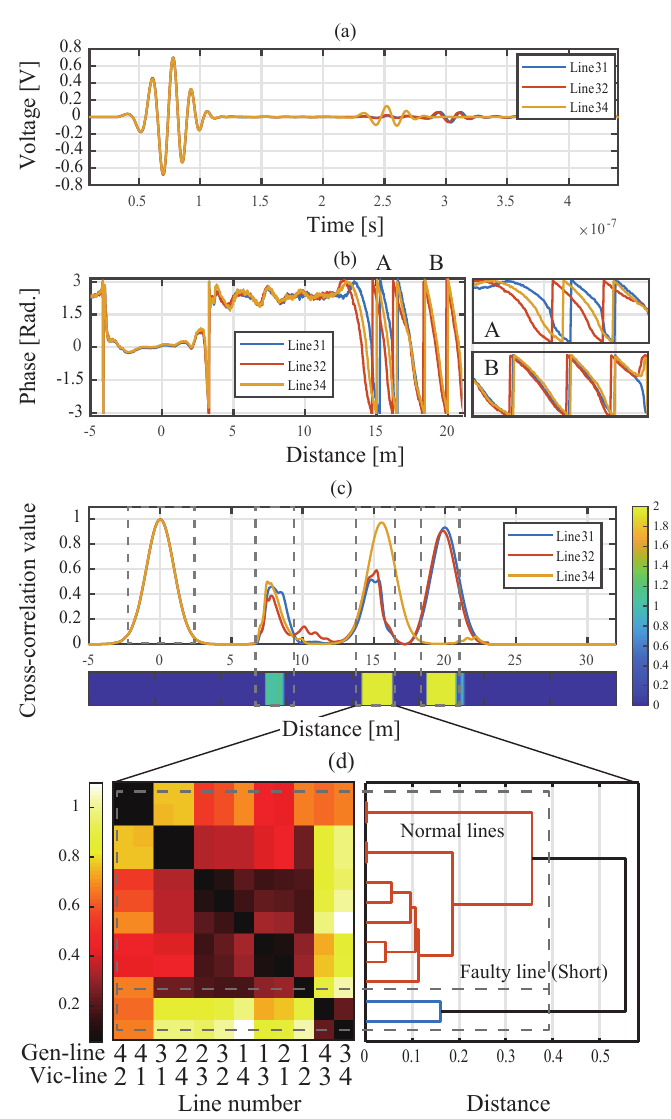
Figure 7. Fault detection and classification results with the Line 3 as the generator line. ( a ) TFDR reflected signals, ( b ) phase estimation results, and ( c ) TFCC and ANN results and ( d ) heat-map representation and hierarchy clustering results on TFDR